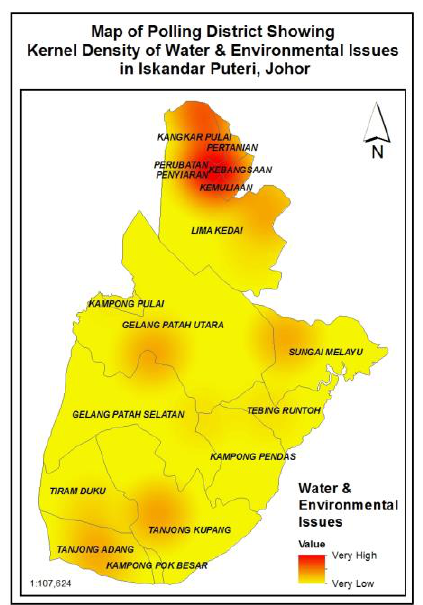
Figure 12. Result of the hot spot maps using KDA for water and environmental issues